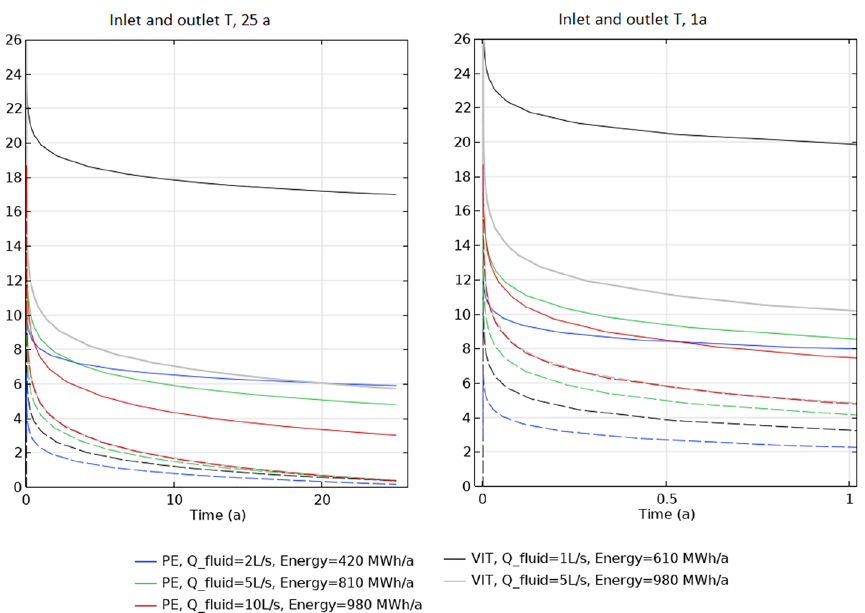
Fig. 5 Outlet (solid line) and inlet (dashed line) temperatures of a 2000-m BHE with VIT or HDPE pipe and different volumetric rates. The left figure presents temperature development over 25 years of simulation and the figure on the right is a close-up of the first year of production